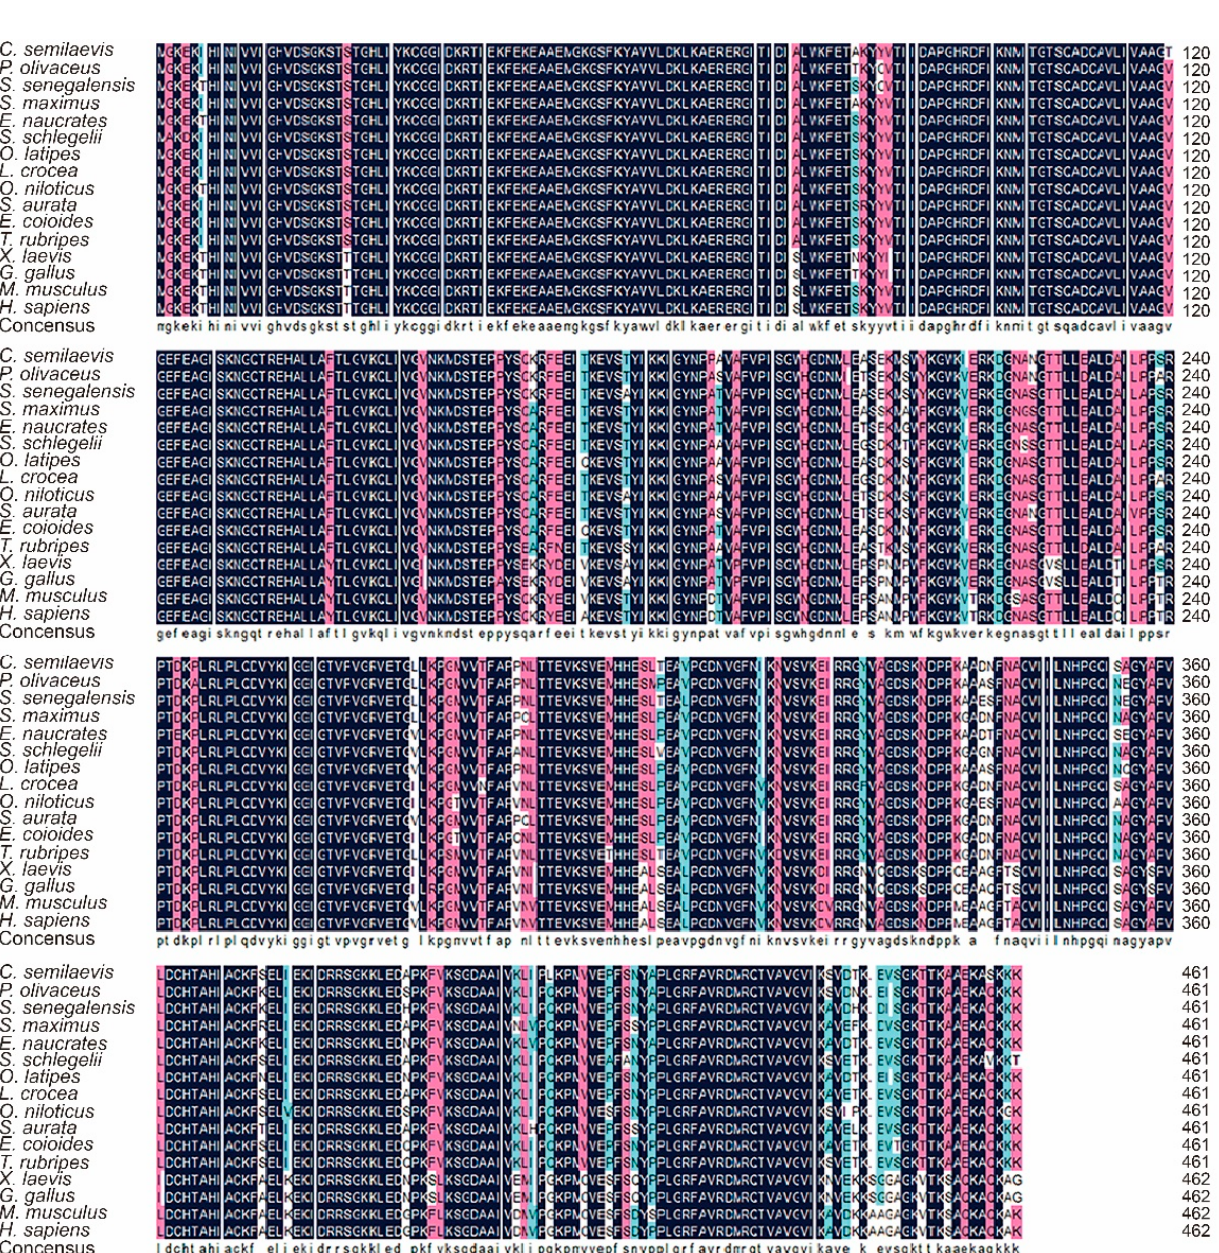
Figure 2. Comparison of C. semilaevis eEF1A1 amino acids with those of other vertebrate orthologues. The sequences were identified by BLAST analysis with the following GenBank accession